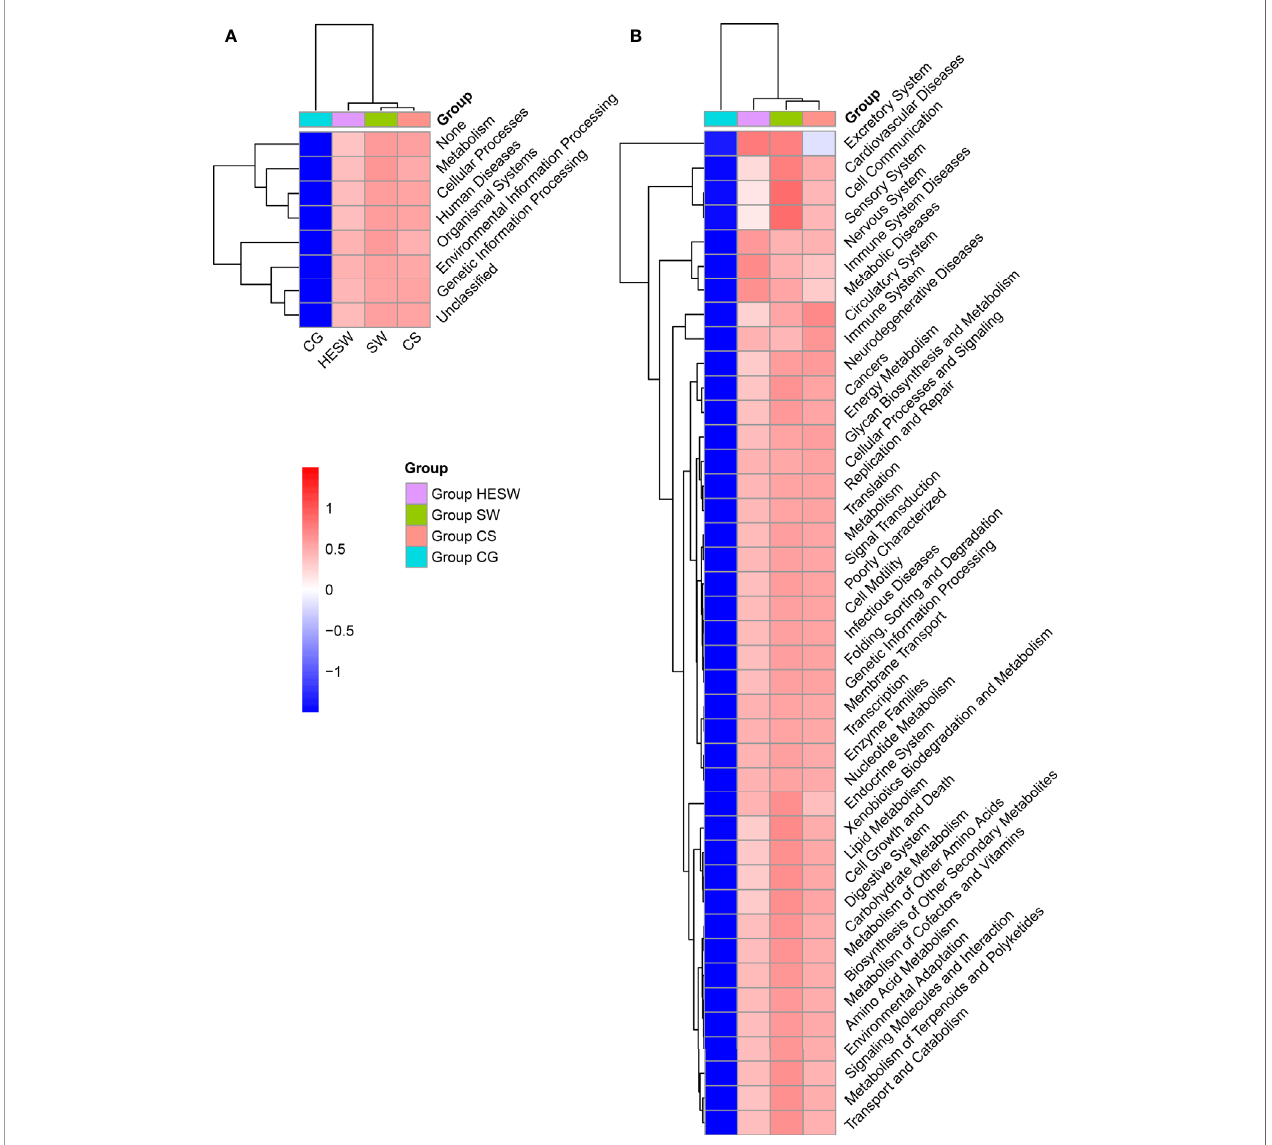
FIGURE 5 | The ocular microbiota of BK patients appeared more active and aggressive. At L1 (A) and L2 (B) level, two-dimensional heat map showing rank normalized abundances (scaled between 0 and 1) of differentially abundant bacterial gene functions determined by Kruskal-Wallis test and KEGG. (HESW, conjunctival swabs from the healthy eyes of BK patients; SW, conjunctival swabs from the diseased eyes of BK patients; CS, corneal scrapings from the diseased eyes of BK